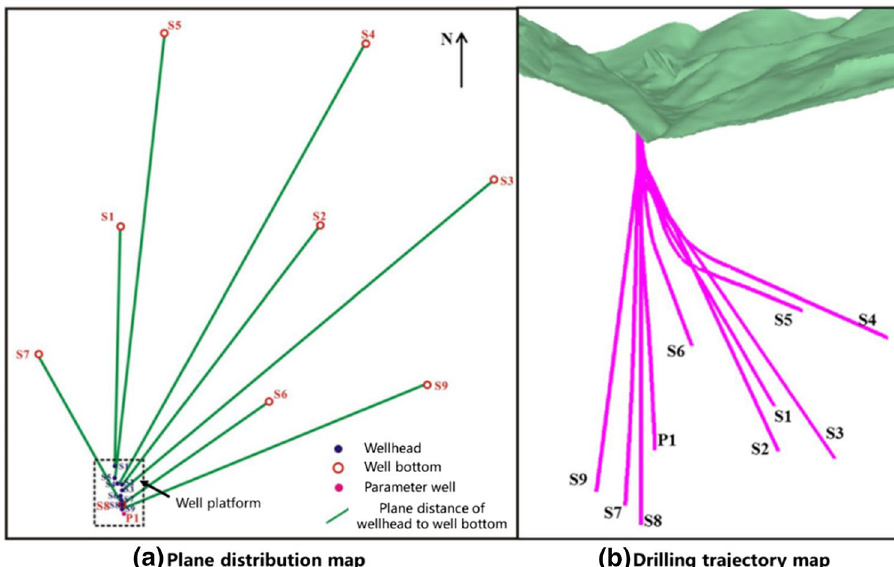
Fig. 3 Schematic of deployment of the cluster well in the Songhe area, Guizhou Province, China (Tang et al.